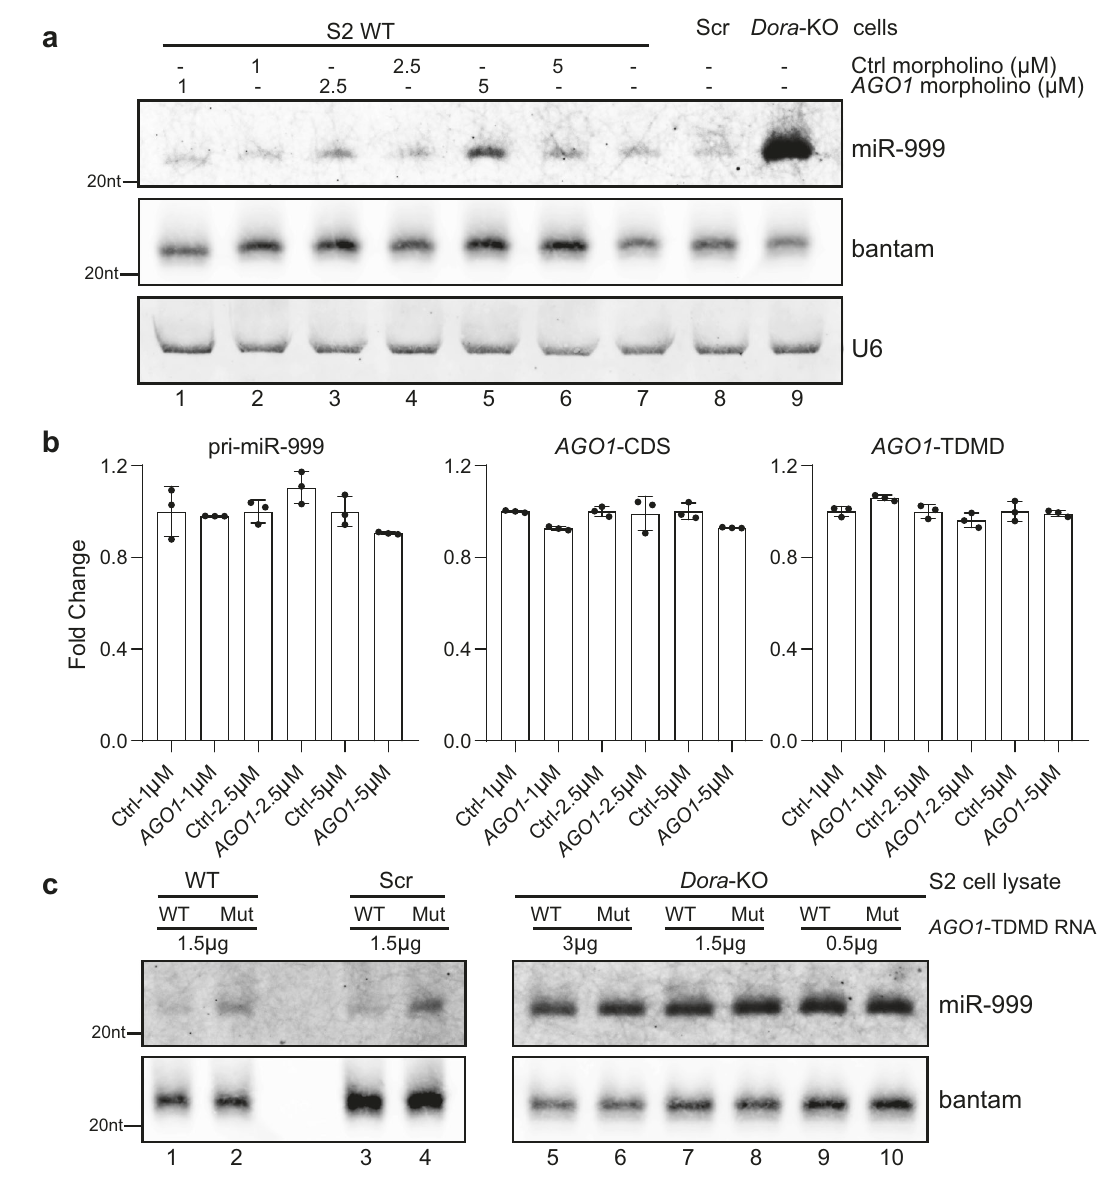
Fig. 5 | Con fi rmation of the AGO1 /miR-999 TDMD pair using morpholino oli- gonucleotides and a cell-free system. a Northern blot analyses of miR-999, ban- tam, and U6 in S2 cells following 48h of 1 µ M, 2.5 µ M, or 5 µ M morpholino oligos treatment. Bantam and U6 served as loading controls. n =3 biological replicates. b RT-qPCR analyses of pri-miR-999, AGO1 -CDS and AGO1 trigger levels in control